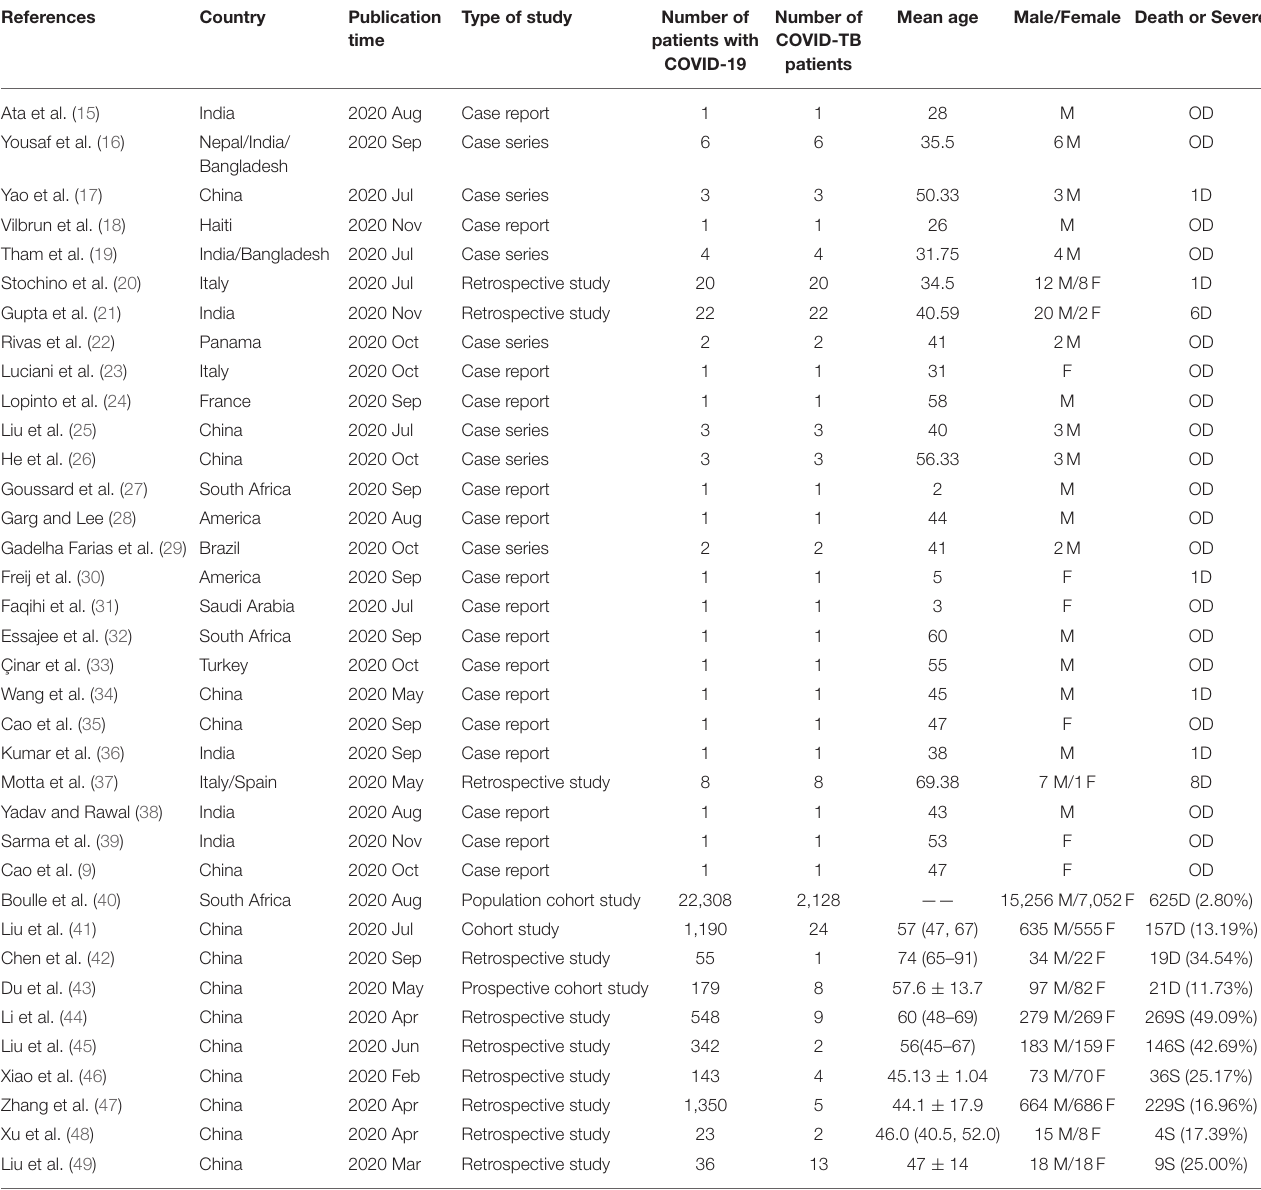
TABLE 1 | Summary of 36 studies included in the systematic